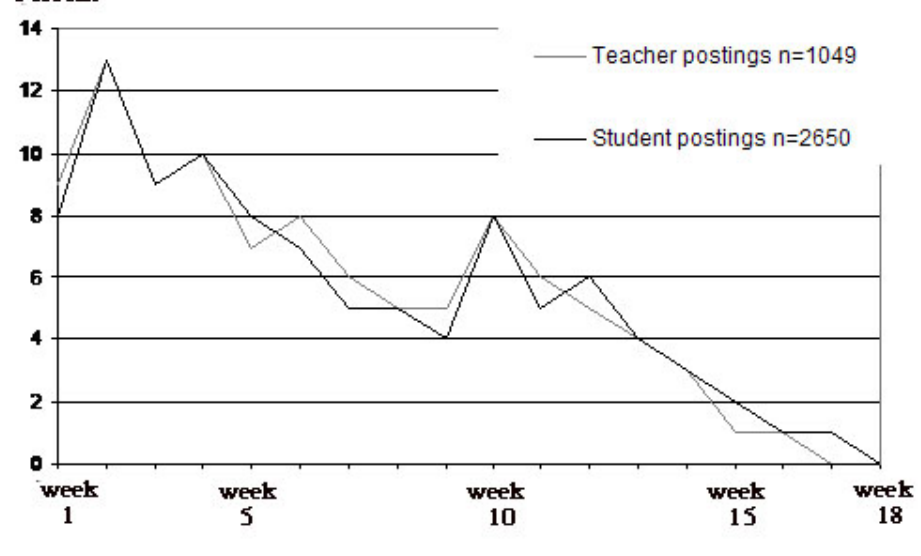
Figure 1. Percentage of student and teacher activity by